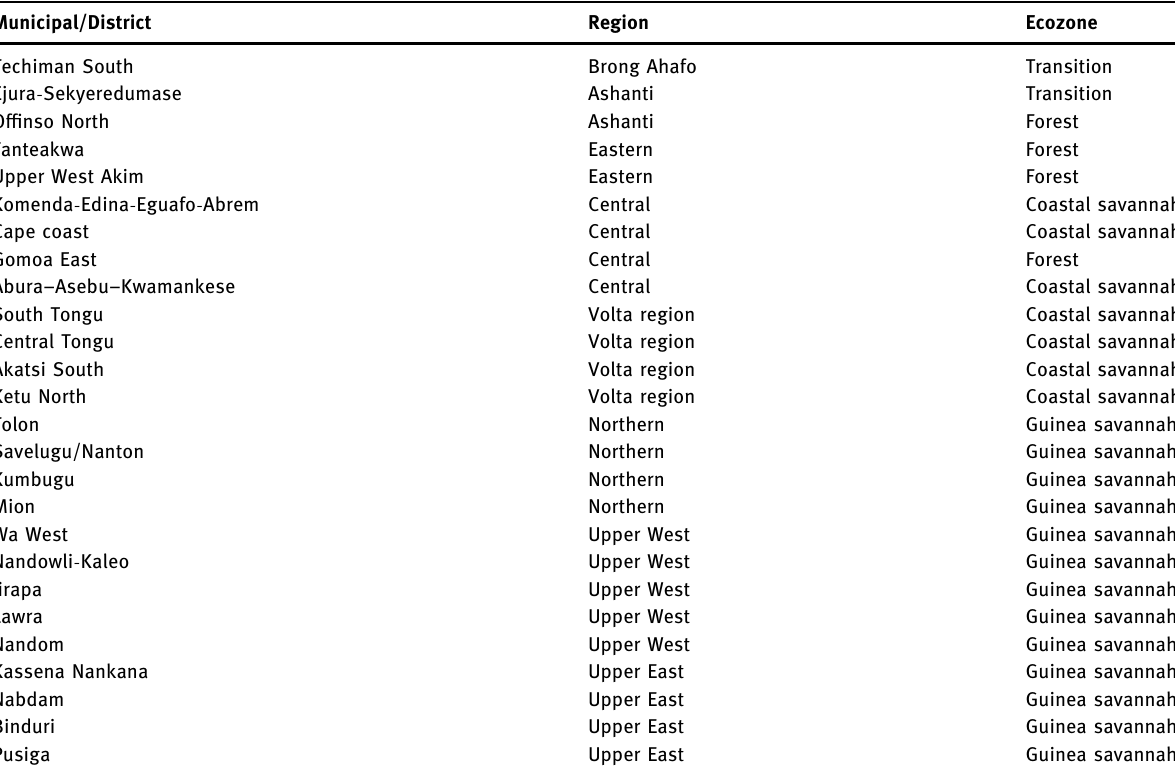
Table 2: Study areas for the multilocational on - farm evaluation Municipal/District